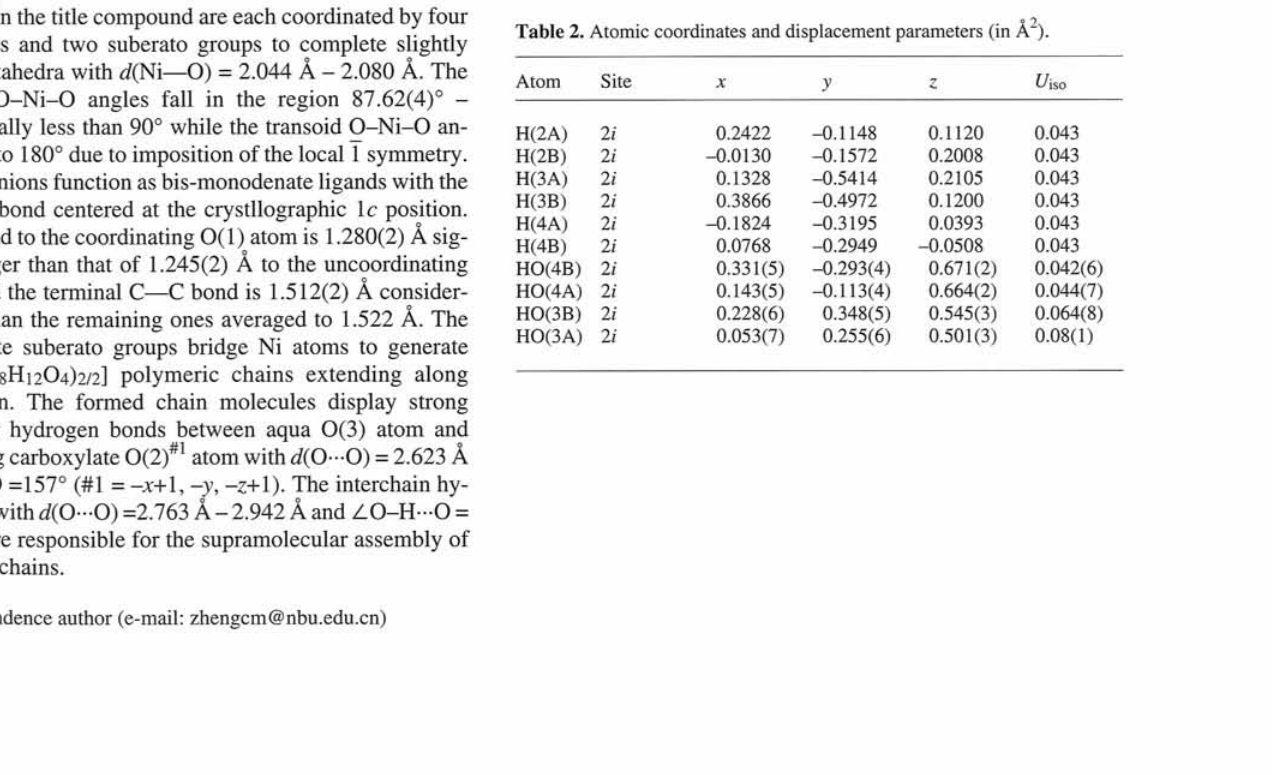
Table 2. Atomic coordinates and displacement parameters (in